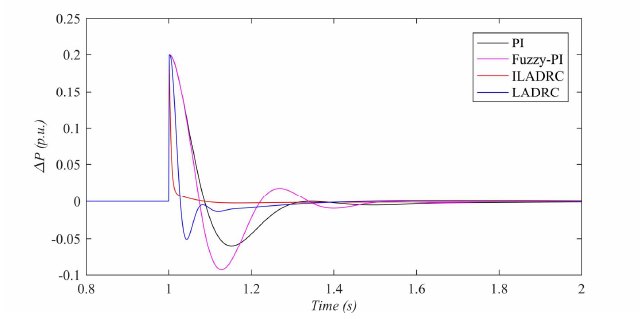
Figure 9. Transient response of system power exchange with − 0.2 p.u. change of load demand.